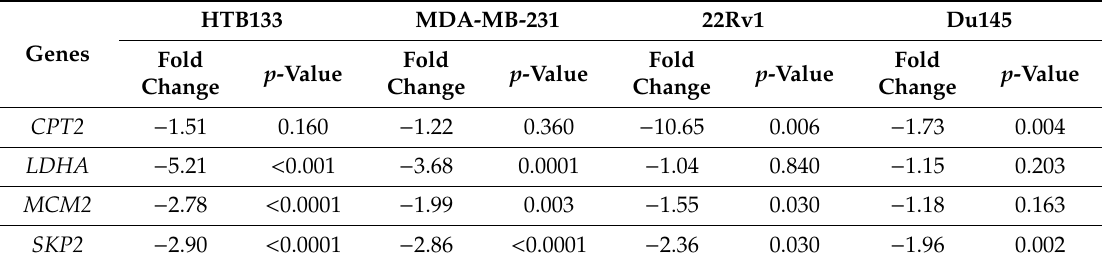
Table 3. CPT2 , LDHA , MCM2, and SPK2 fold change values between the vehicle and the [C16Pyr][Amp] treatment conditions for the selected BrCa and PCa cell